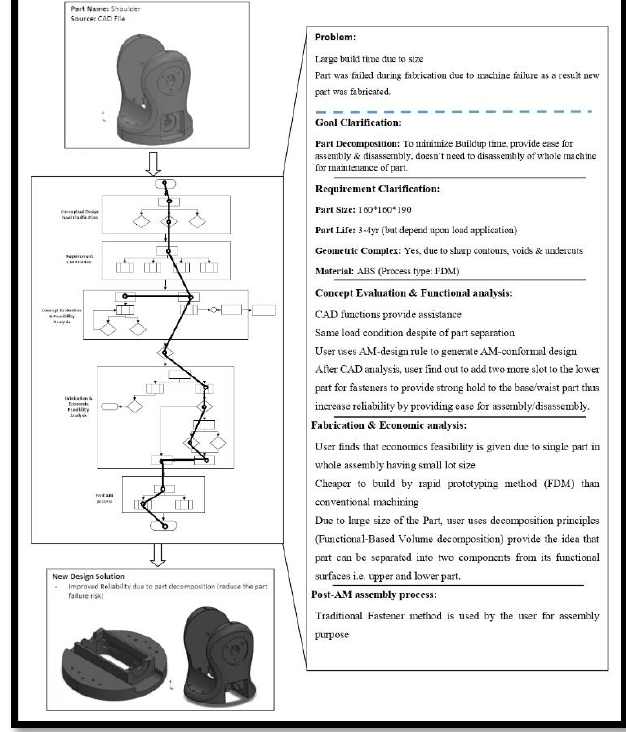
Fig. 11. Example: implementation of proposed DSS (part decomposition).